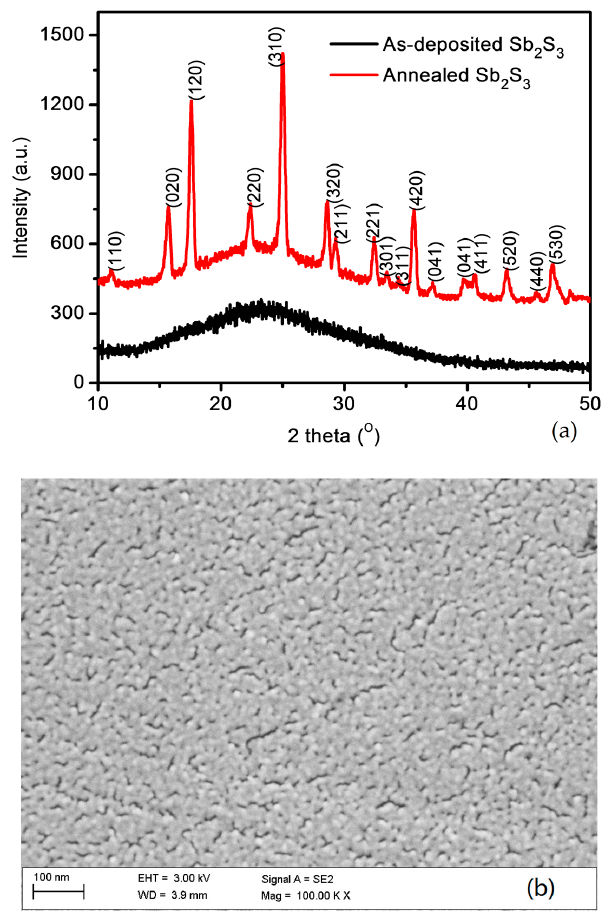
Figure 2. ( a ) XRD patterns for the Sb 2 S 3 thin films and ( b ) the SEM of the surface morphology of the annealed Sb 2 S 3 films.